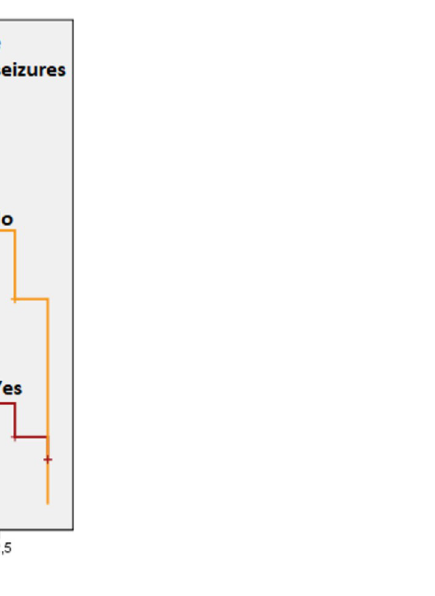
Fig 9. Kaplan-Meier survival curves of patients in Engel class Ia by seizure semiology.